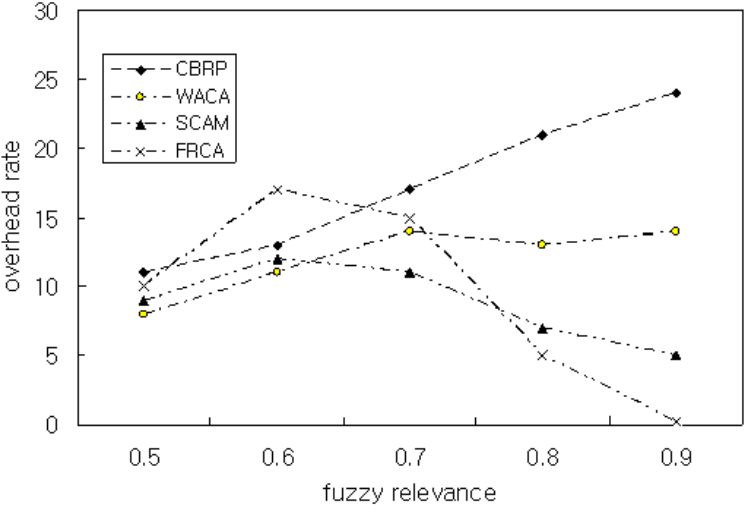
Figure 7. Overhead Rate with 0.5    0.9.